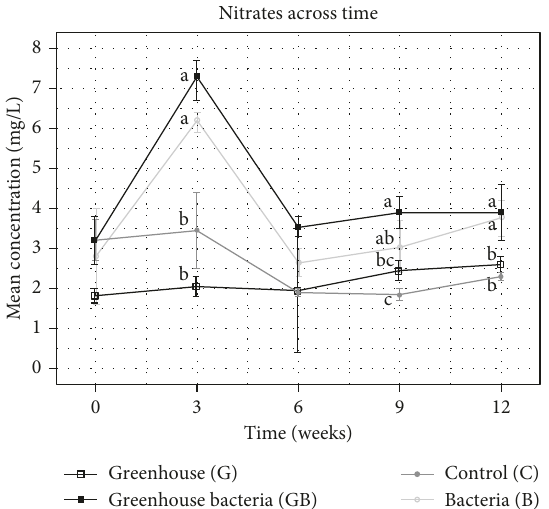
Figure 4: Nitrite concentrations per treatment across time. Means within a time measured followed by the same letter are not sig- nificantly different according to the Tukey–Kramer test or Nemenyi test in case of no normality.